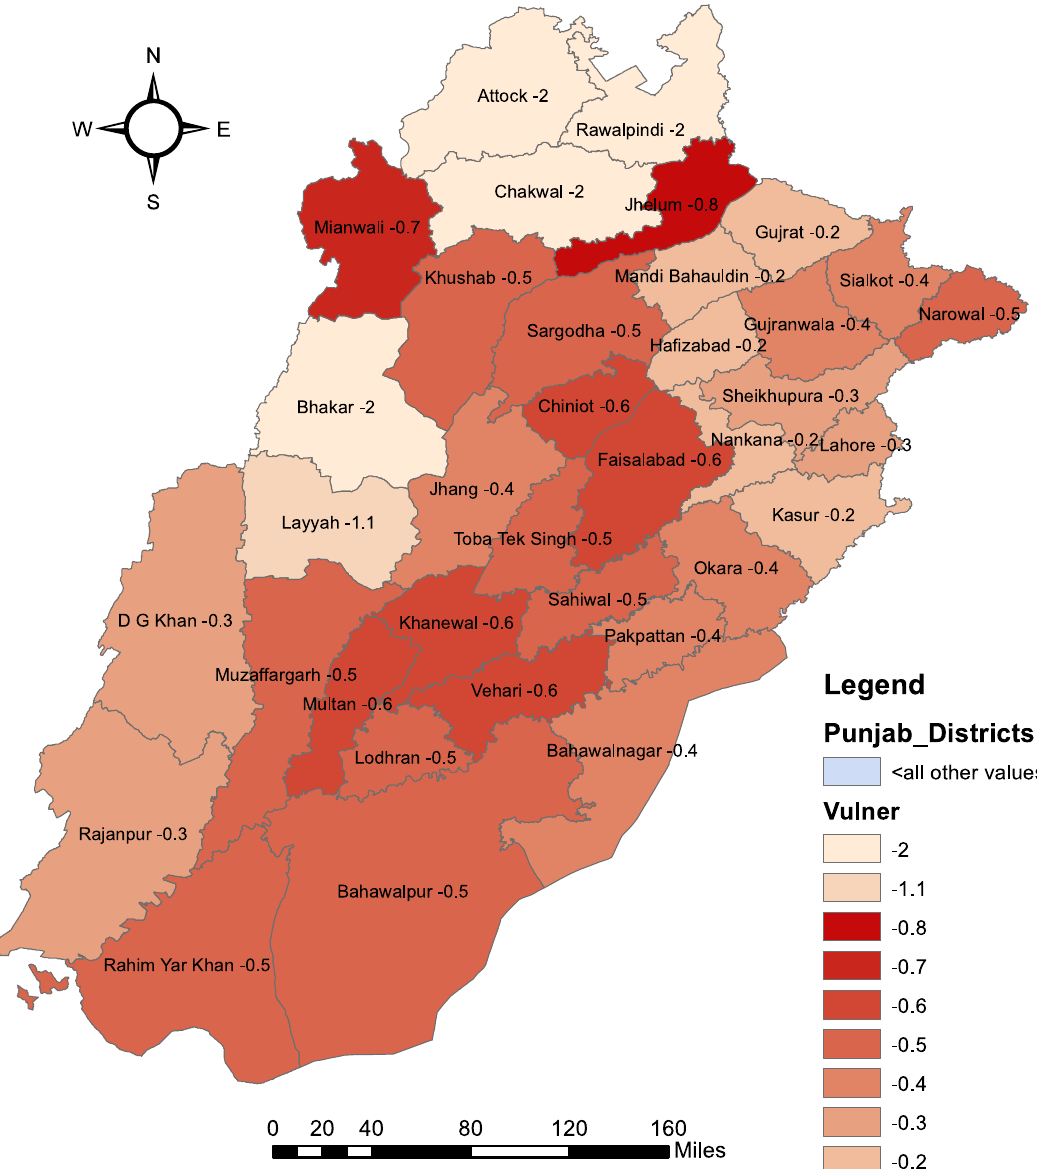
Figure 4. Spatial mapping of climate induced district vulnerability ranking for rice yield. Source Generating using Arc GIS version